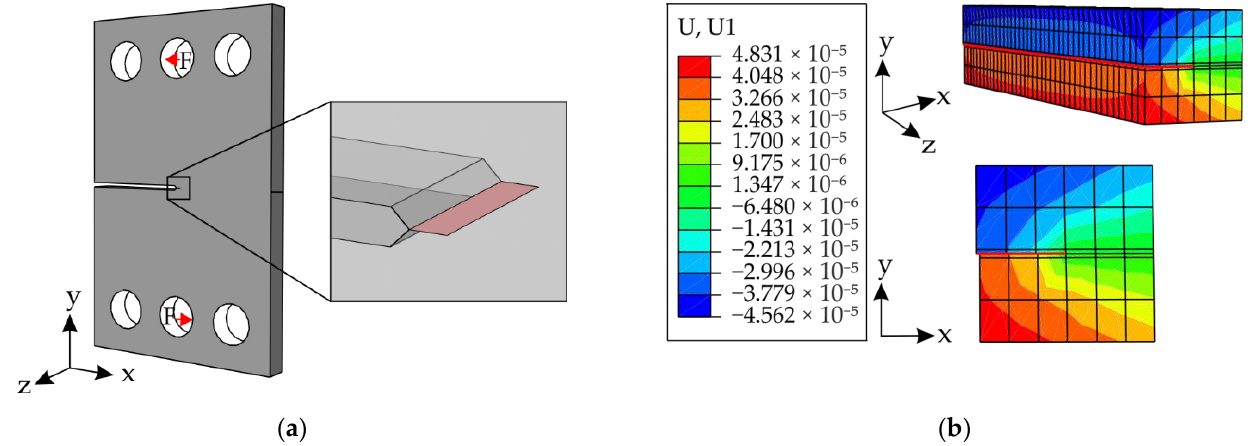
Figure 12. Models of CTS specimen and submodel: ( a ). The input model of CTS specimen along with the initial crack; ( b ) The submodel with the new geometry created for the initial crack.